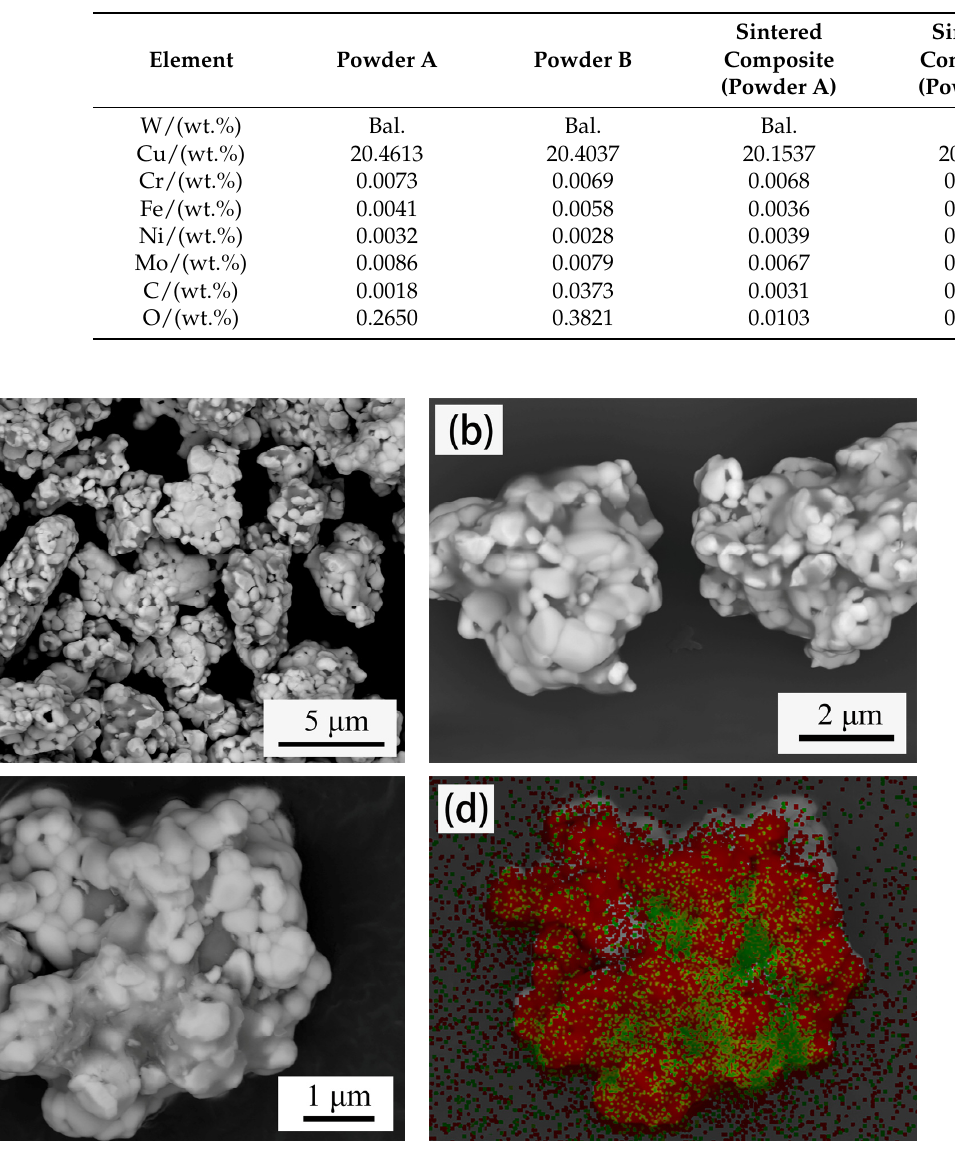
Figure 2. Micromorphology of W–20% Cu powders after bonding treatment and ball milling (BTBM, Powder B). ( a ) 5000 × magnification; ( b ) 10,000 × magnification; ( c ) 15,000 × magnification; ( d ) EDX mapping analysis of (c).